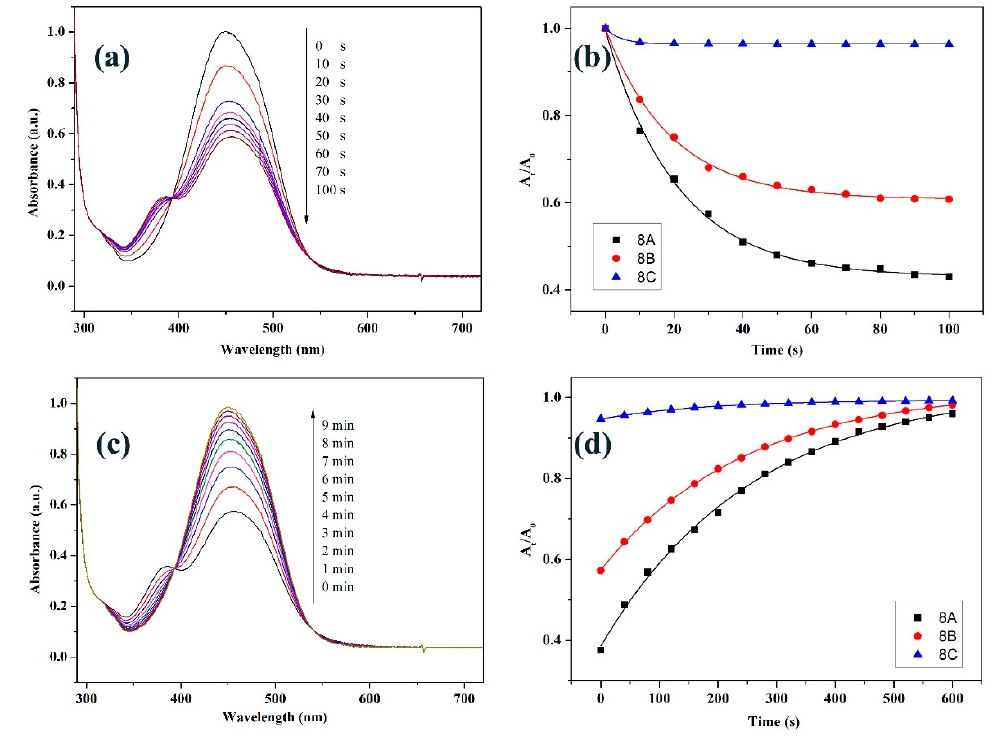
Figure 4. UV-vis spectra of solution of 8B irradiated with 450 nm light ( a ) and in the dark after reaching photo-stationary state ( c ); relative absorbance at λ max and the corresponding fitted curves for solutions of 8A , 8B , and 8C during the trans - cis ( b ) and cis - trans ( d ) isomerization. Photoinduced isomerization of the spin-coated film of 8A , 8B , and 8C is further investigated as